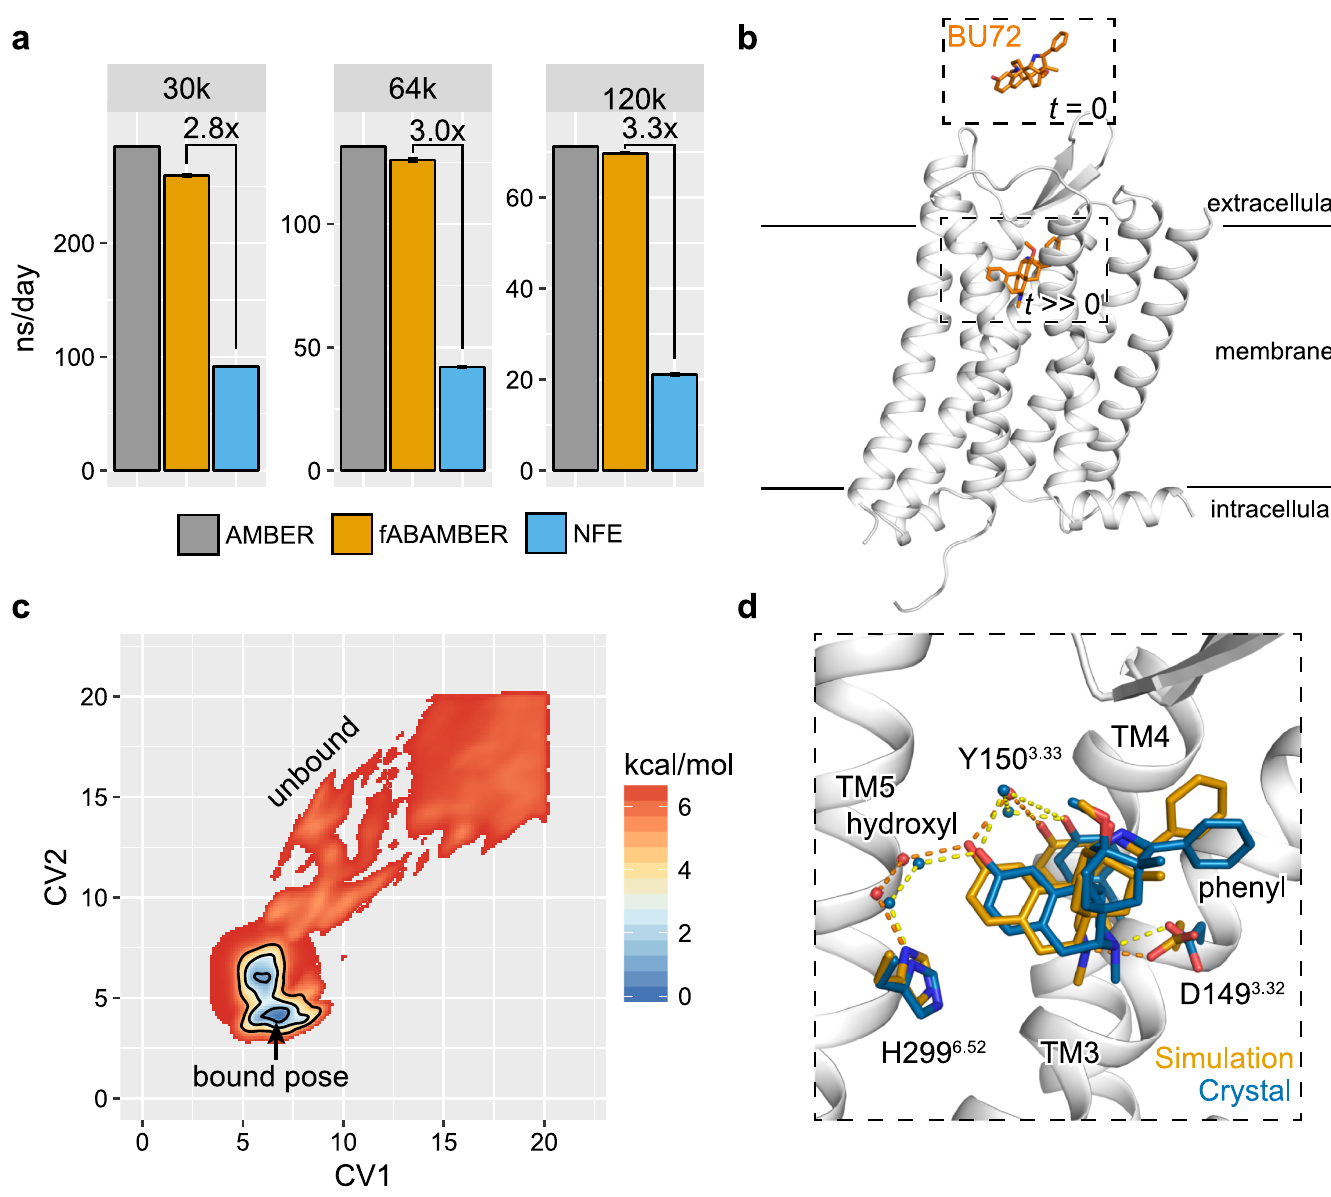
Fig 1. fABAMBER benchmarking and application to ligand binding. a, fABAMBER performance compared to AMBER’s native GPU enabled simulation engine and NFE toolkit for systems comprising 30k, 64k, and 120k atoms. b, Example initial system configuration for ligand binding simulations where the μ OR is represented in white and the morphine derived agonist BU72 is shown in orange. c, Averaged free energy landscape for BU72 mABP ligand binding simulations. Contours are drawn at 1, 3, and 5 kcal/mol. d, Structural overlap of BU72’s predicted low-energy conformation (white cartoon and orange sticks) and crystallographic position (PDB Code: 5C1M;